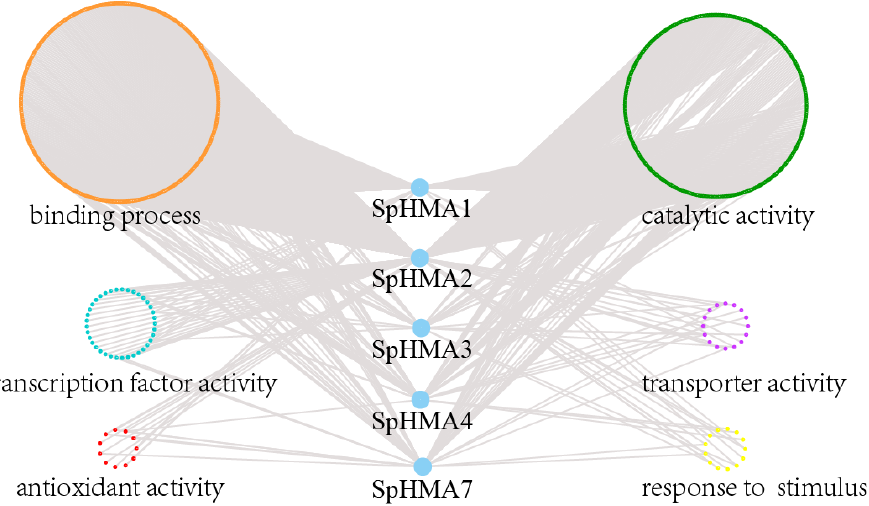
Figure 5. Co-expression regulatory network of SpHMA genes in S. plumbizincicola . Nodes represent- ing individual genes and edges stand for significant co-expressions between genes. Genes involved in the same biological process are grouped together and filled with different colors: binding process (orange), catalytic activity (green), antioxidant activity (red), transporter activity (purple), transcrip- tion factor activity (blue) and response to stimulus (yellow).